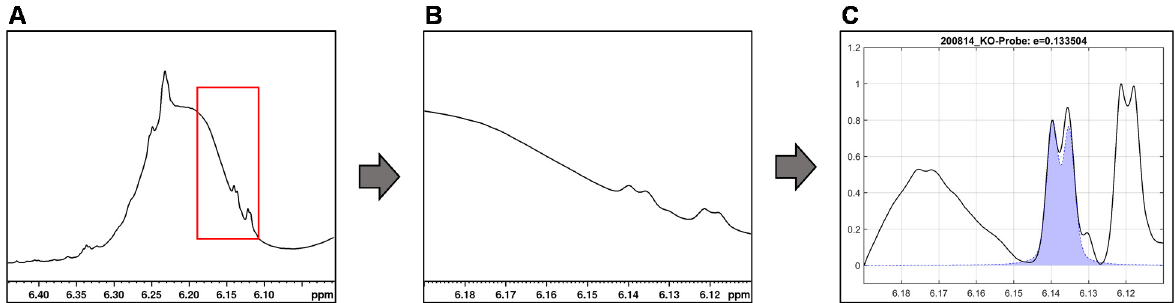
Figure 6. Integration by mathematical curve fitting in MatLab using the example of the ∆ 9 -THC signal. ( A ) ∆ 8 / ∆ 9 -THC overlapped by the CBD hump with region of interest highlighted in red. ( B ) Extracted region of interest. ( C ) Baseline correction and signal fit (purple filled curve) by searching a defined signal range for specific coupling and maximum for minimal matrix interference.